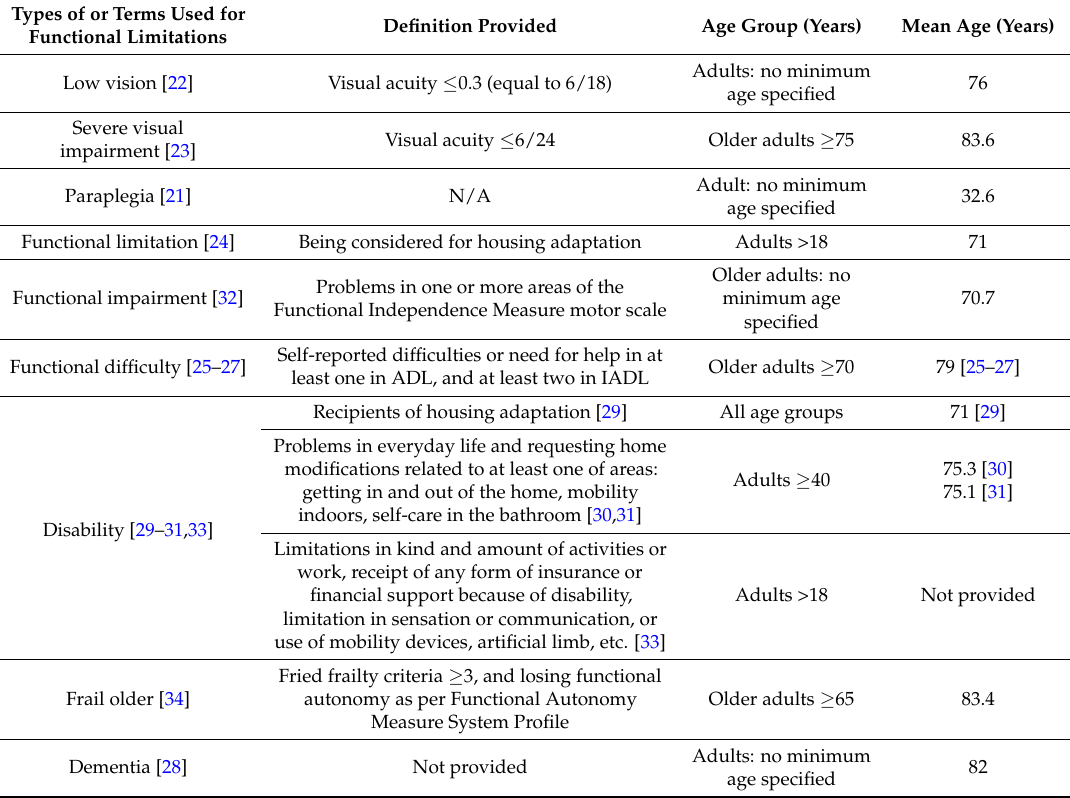
Table 2. Descriptions of functional limitations in studies